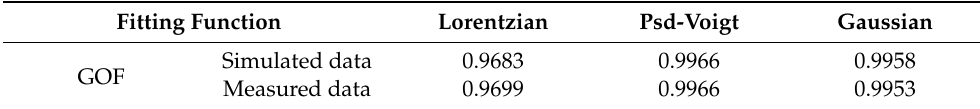
Figure 6. A typical Eu 3+ photoluminescence spectrum and fitting results. ( a ) Lorentzian; ( b ) Psd-Voigt; ( c ) Gaussian. Table 2. GOF values for different functions used to fit Eu 3+ fluorescence